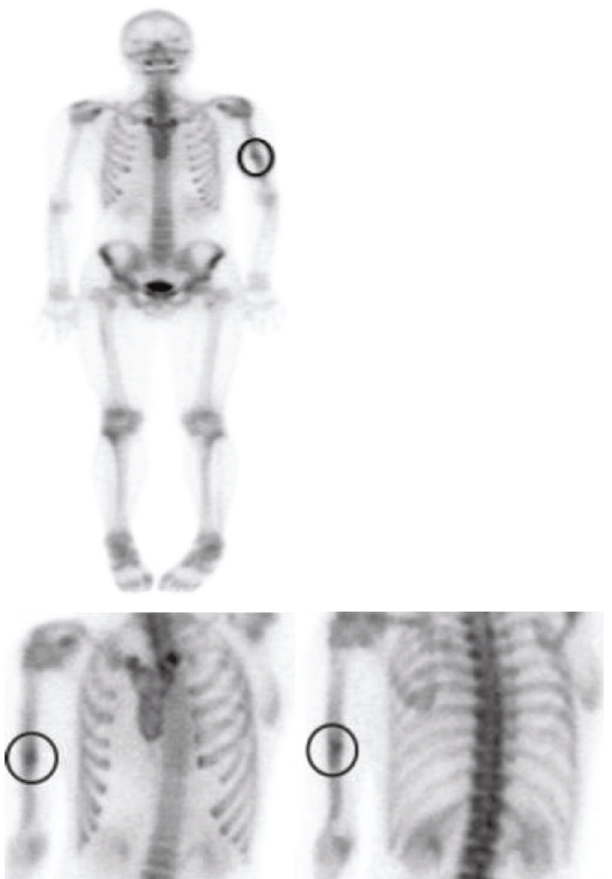
Figure 4: Bone scintigraphy showing intense accumulation at the nonunion site of the left humerus. The black circles indicate the nonunion